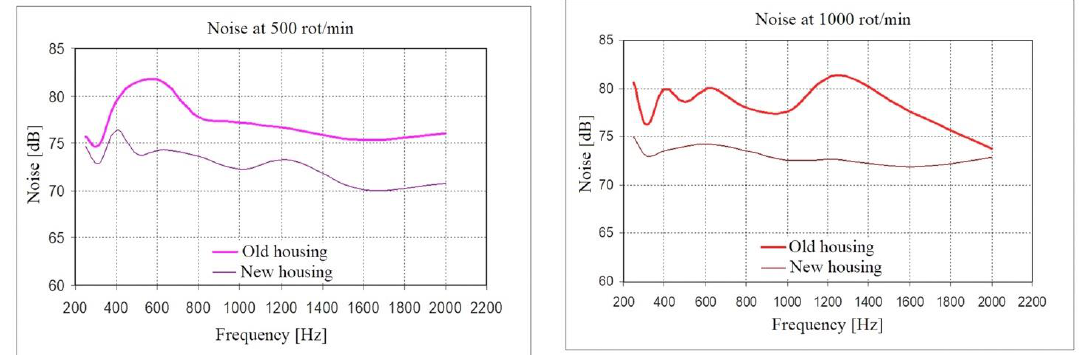
Figure 30. Lp sound pressure level diagrams for front surface at 500 and 1000 rpm.